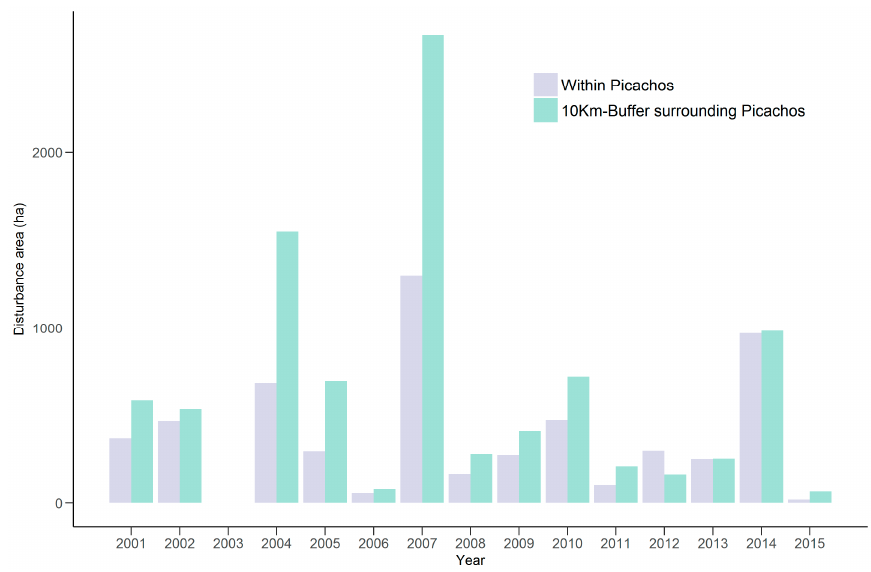
Figure 6. Temporal distribution of disturbance area within Picachos and the surrounding region. The year 2003 was not evaluated because of a lack of Landsat images.